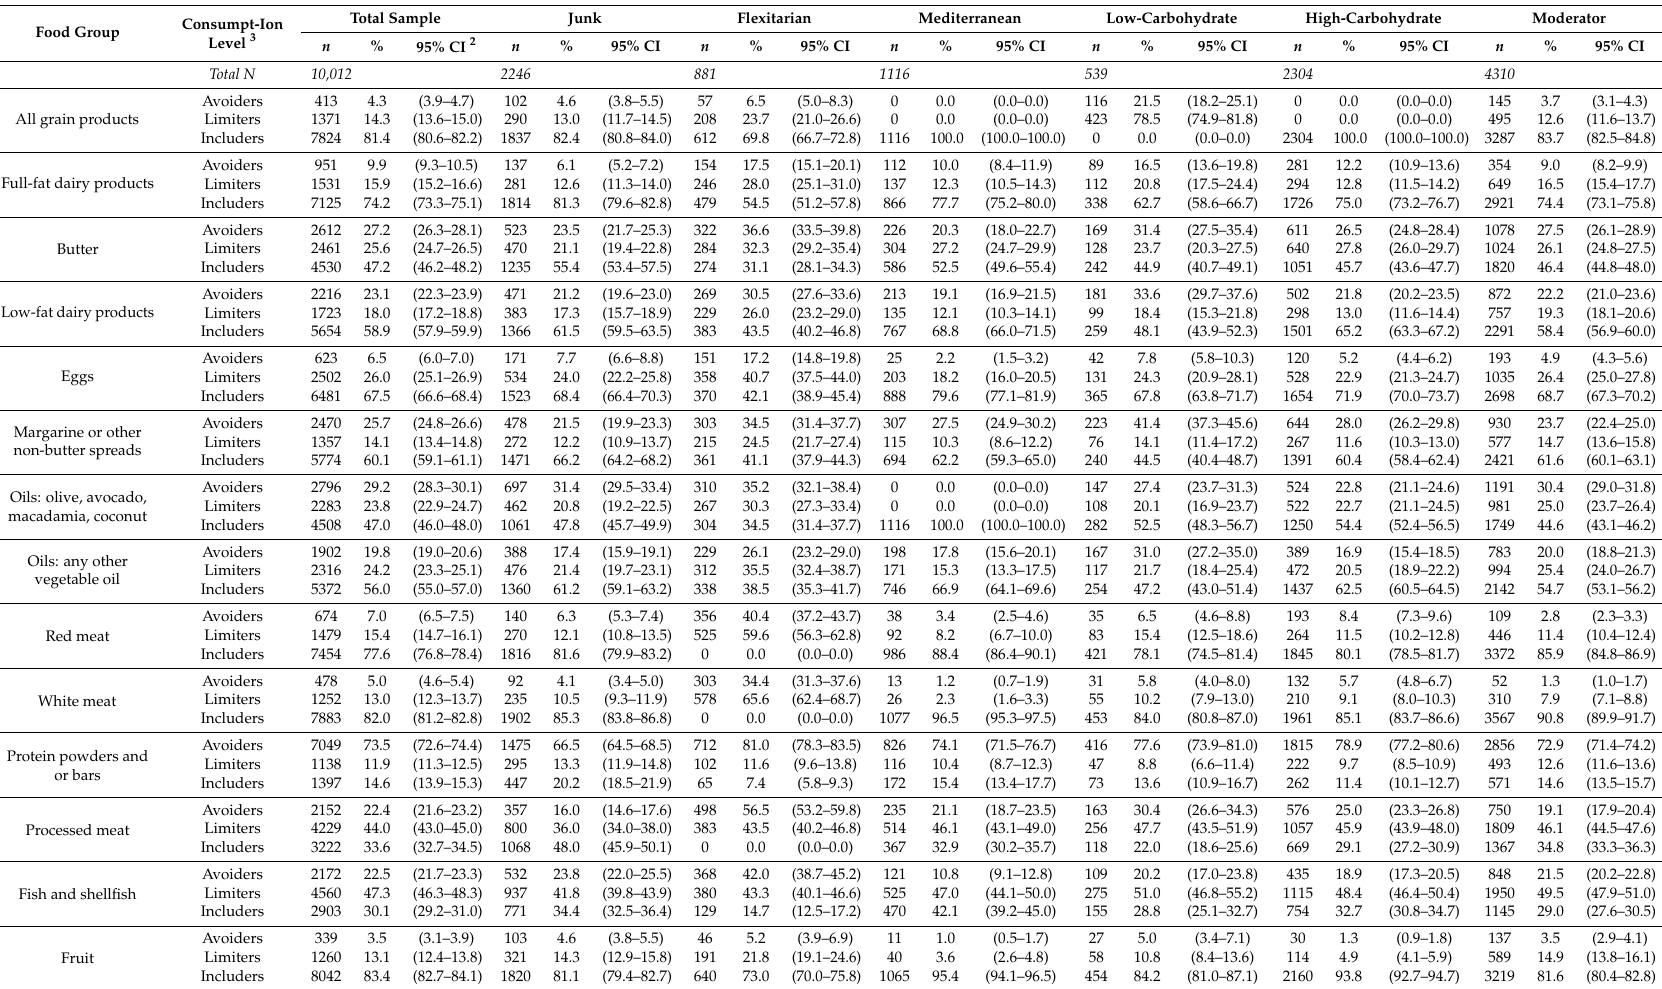
Table 3. The prevalence of different food groups across profile groups 1